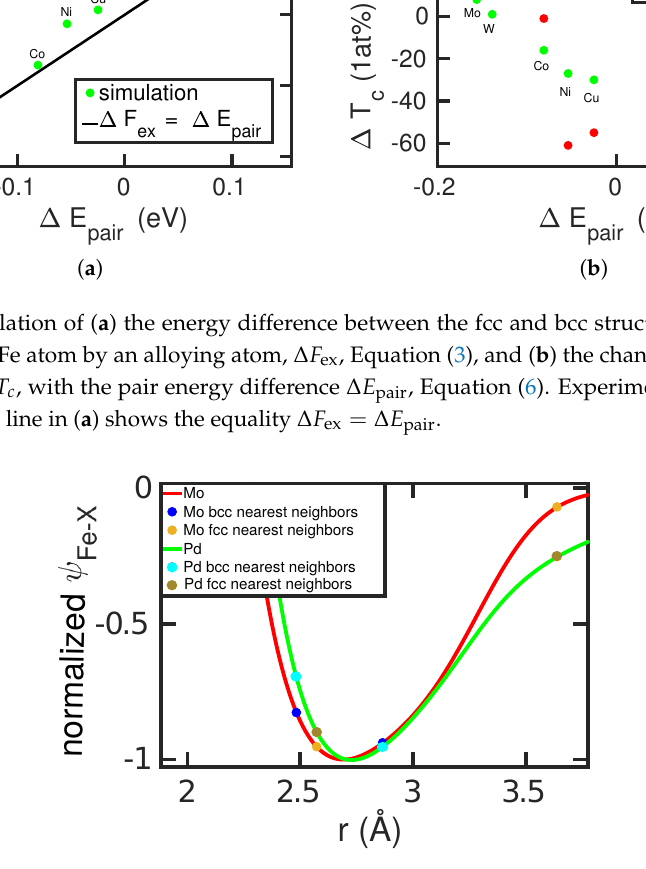
Figure 7. Pair potential of the Fe–X interaction, ψ FeX , for Mo and Pd atoms, normalized to its value at the minimum, r min . The first and second nearest-neighbor distances in the Fe bcc and fcc lattices are